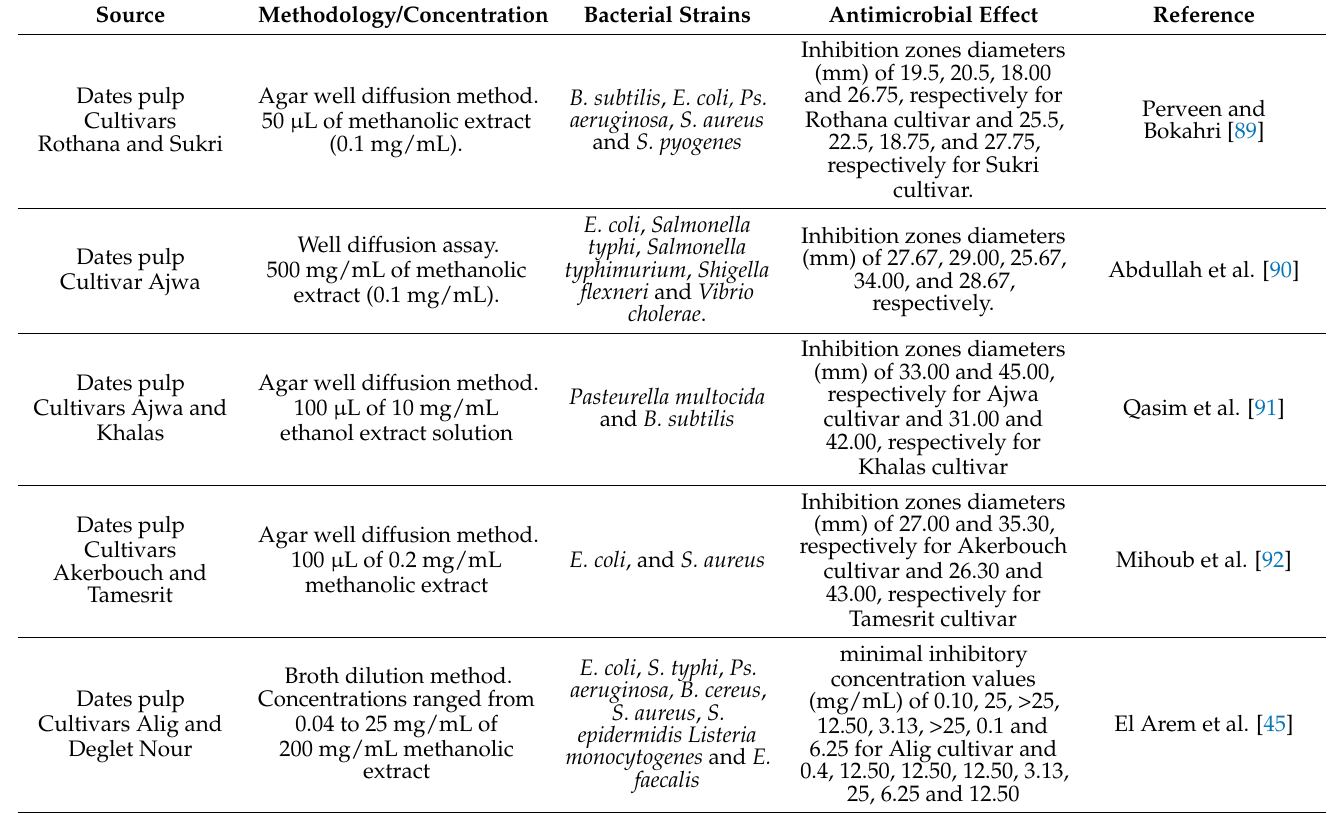
Table 4. Antibacterial activity of pulp and seeds extracts obtained from different date fruit cultivars. Source